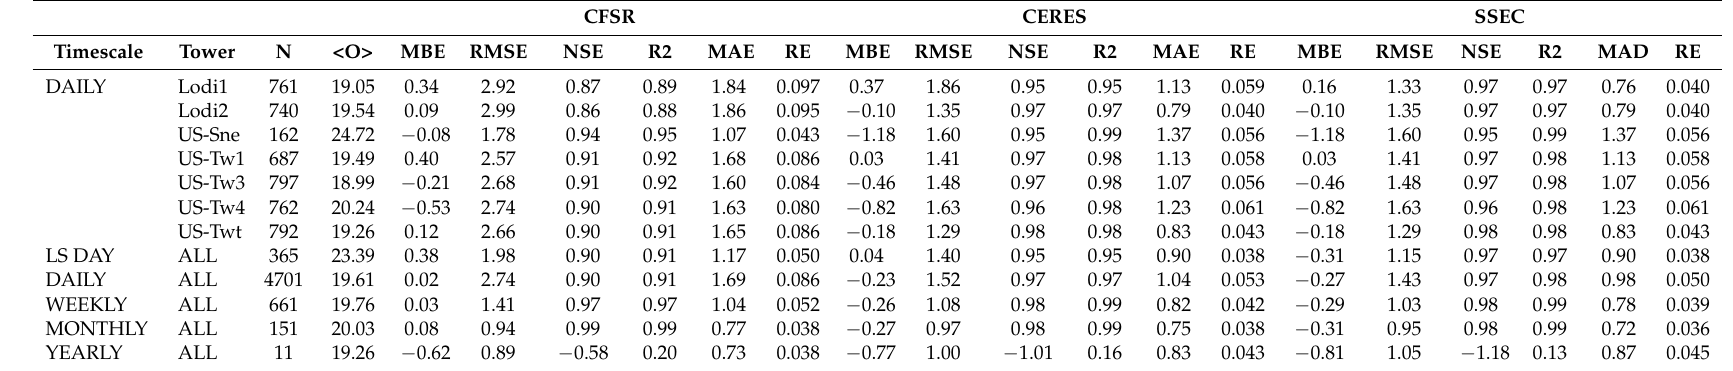
Table 2. Statistical metrics of insolation dataset performance at flux sites on clear Landsat overpass dates (LS day) and at daily, weekly, monthly, and yearly timesteps, reported in units of MJ · m − 2 · d − 1